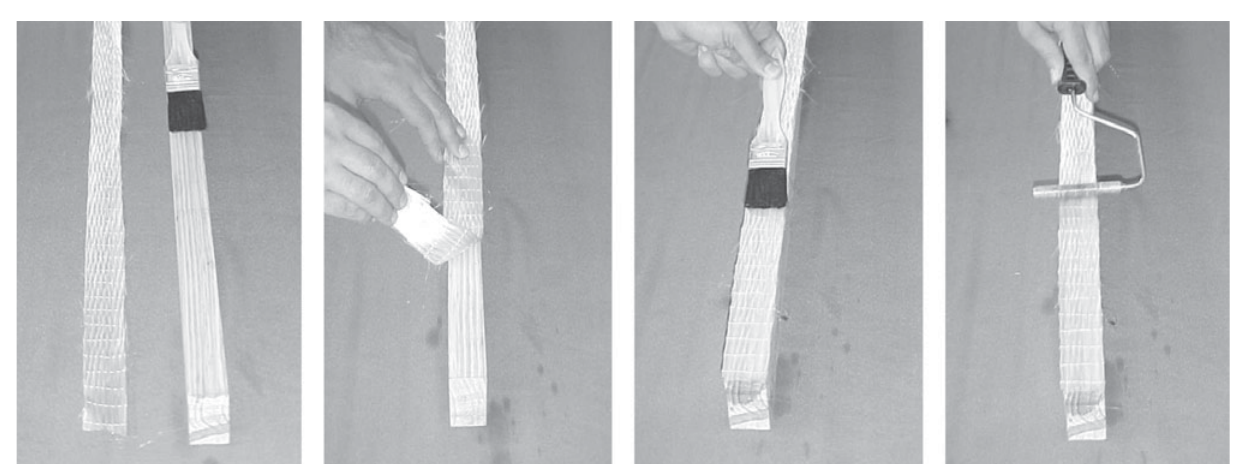
Figure 2. Procedure of application of glass fibers in timber beams.